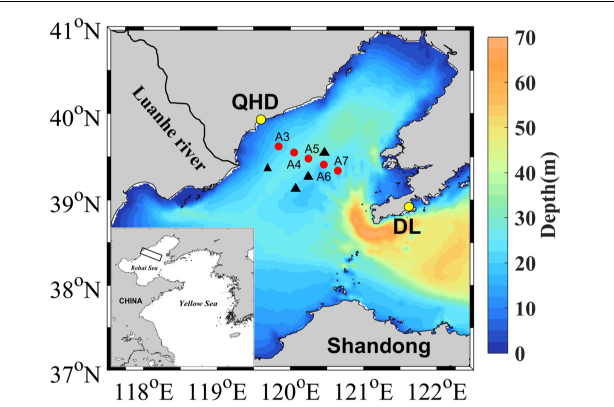
FIGURE 1 | Map of sampling stations. See Table 1 for the coordinates of the sampling stations and other sampling information. Red points denote stations sampled in 2017 and 2018 and the black triangles represent stations visited in June and August 2011 by Zhai et al. (2012) (see section Oxygen Depletion and Acidification in the Bottom Layer). QHD and DL denote Qinhuangdao City and Dalian City,